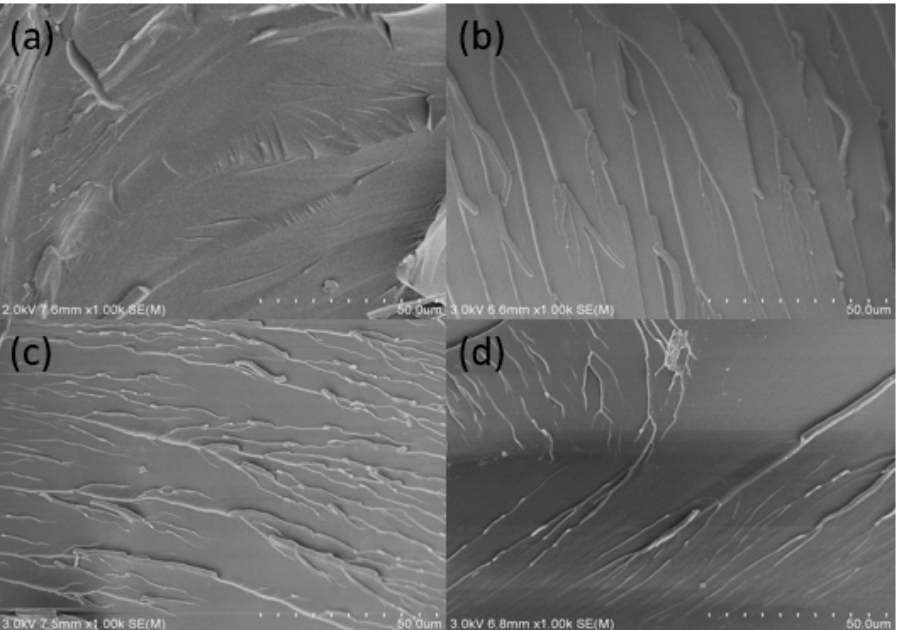
Figure 6. SEM images of the impact fracture surfaces of ( a ) neat epoxy; ( b ) TA–COOH0.5; ( c ) TA– COOH1.5; and ( d ) TA–COOH2.0.